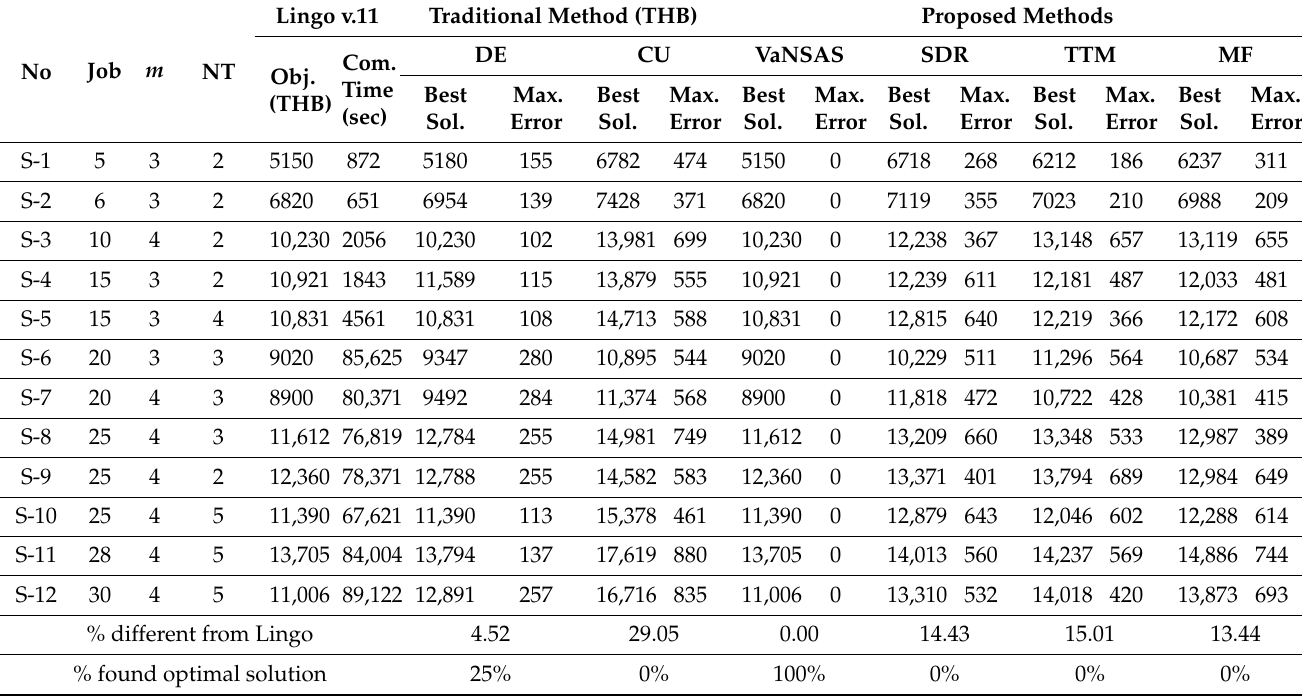
Table 9. Computation results of small test